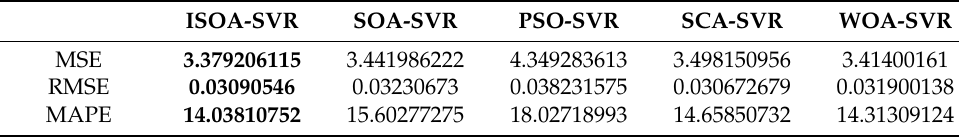
Table 8. The results of MSE, RMSE and MAPE of five models in Experiment